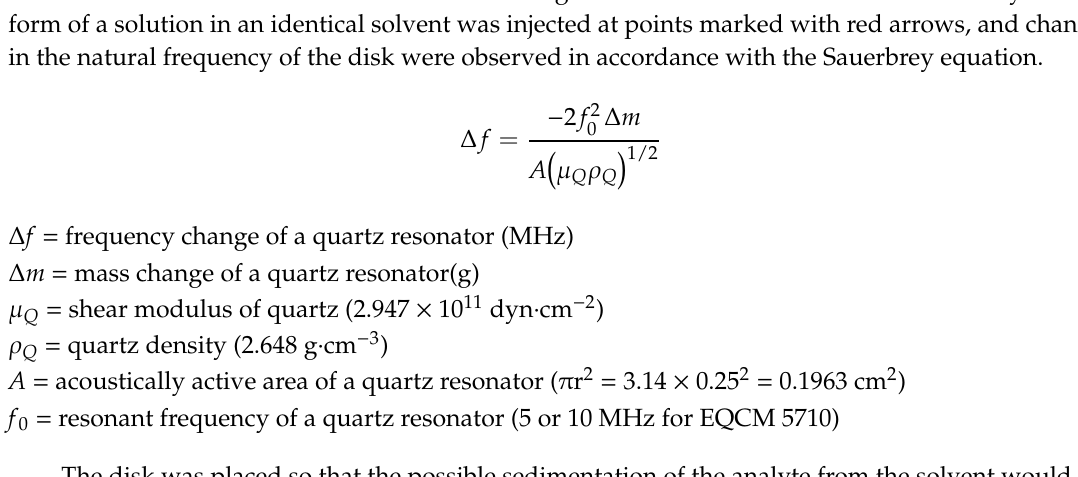
Figure 9. Structures of studied polymer—S XVIII Mn = 6850, D = 1.35 (* means places of chain